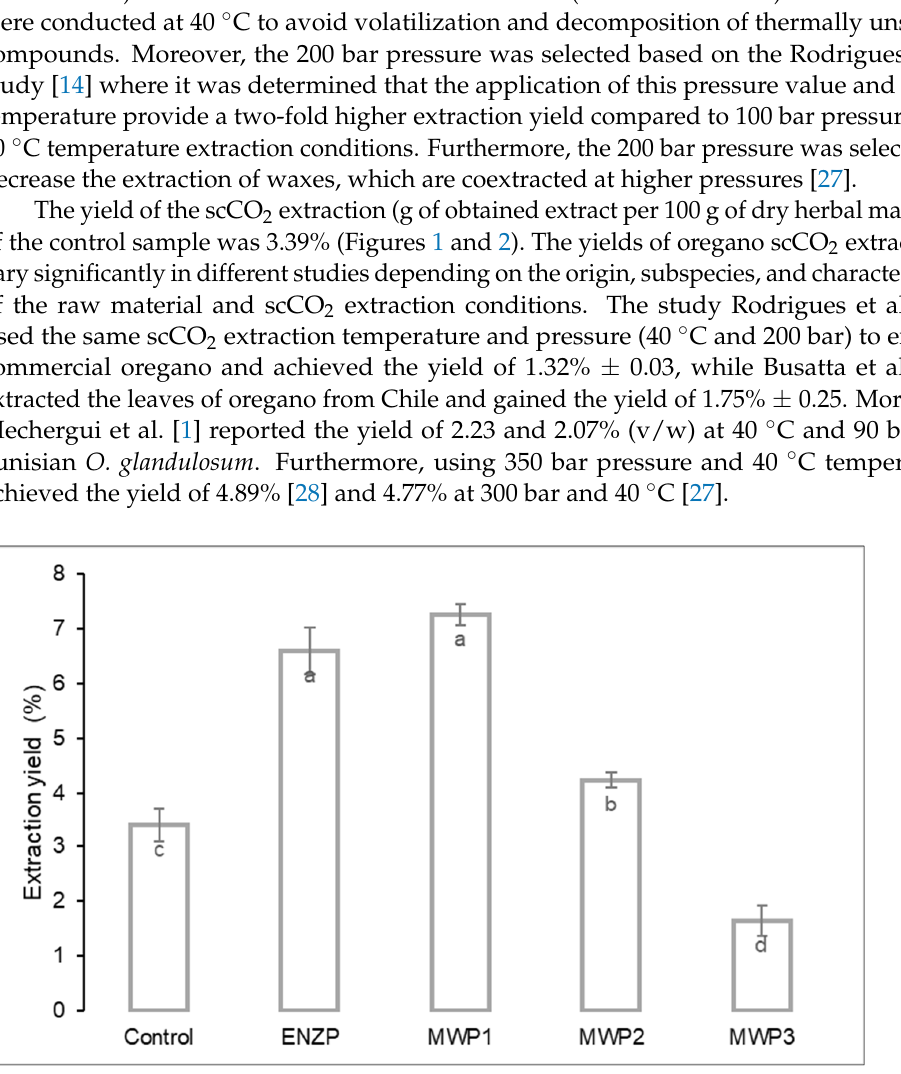
Figure 1. Total extraction yield of supercritical carbon dioxide extraction (pressure 200 bar, temperature 40 °C, extraction time 4 h) of pretreated samples and control. Different letters (a, b, c, d) indicate significant difference between samples ( p < 0.05).